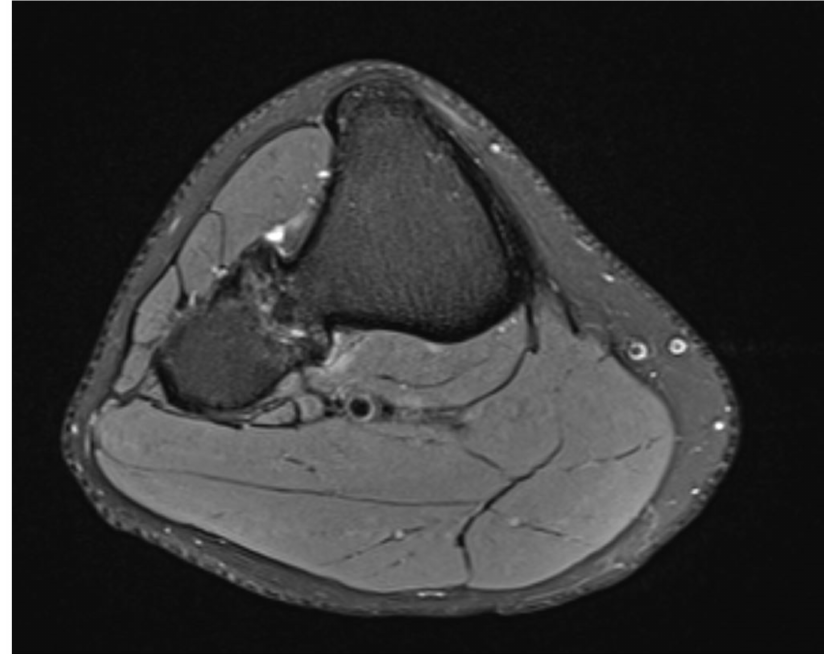
Figure 3. MRI scan in horizontal view showing the synostosis of the right